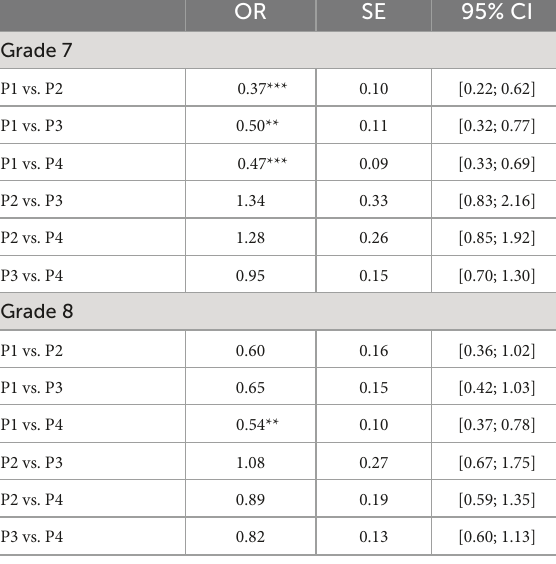
TABLE 7 Effect of gender on latent profile membership.